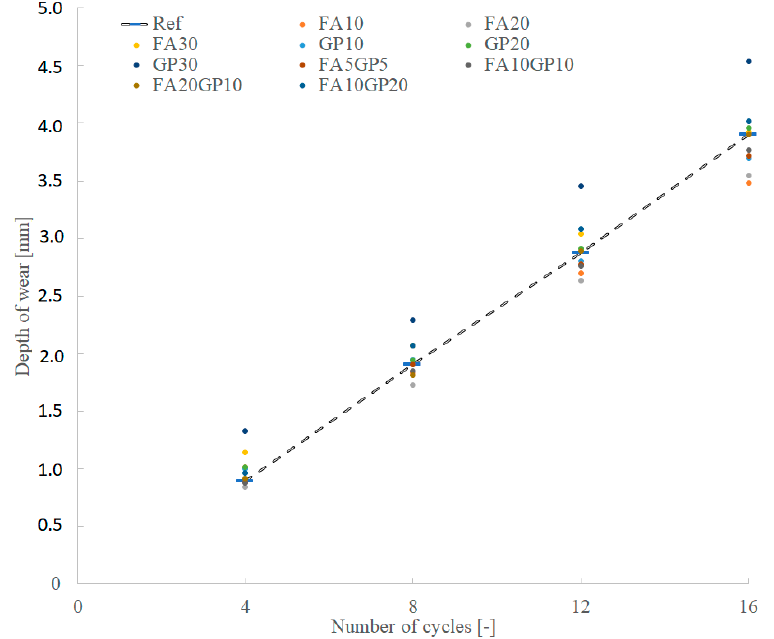
Figure 6. The results of the depth of wear in comparison with the reference sample. The results presented in Figures 5 and 6 were based on the depth of wear parameter.